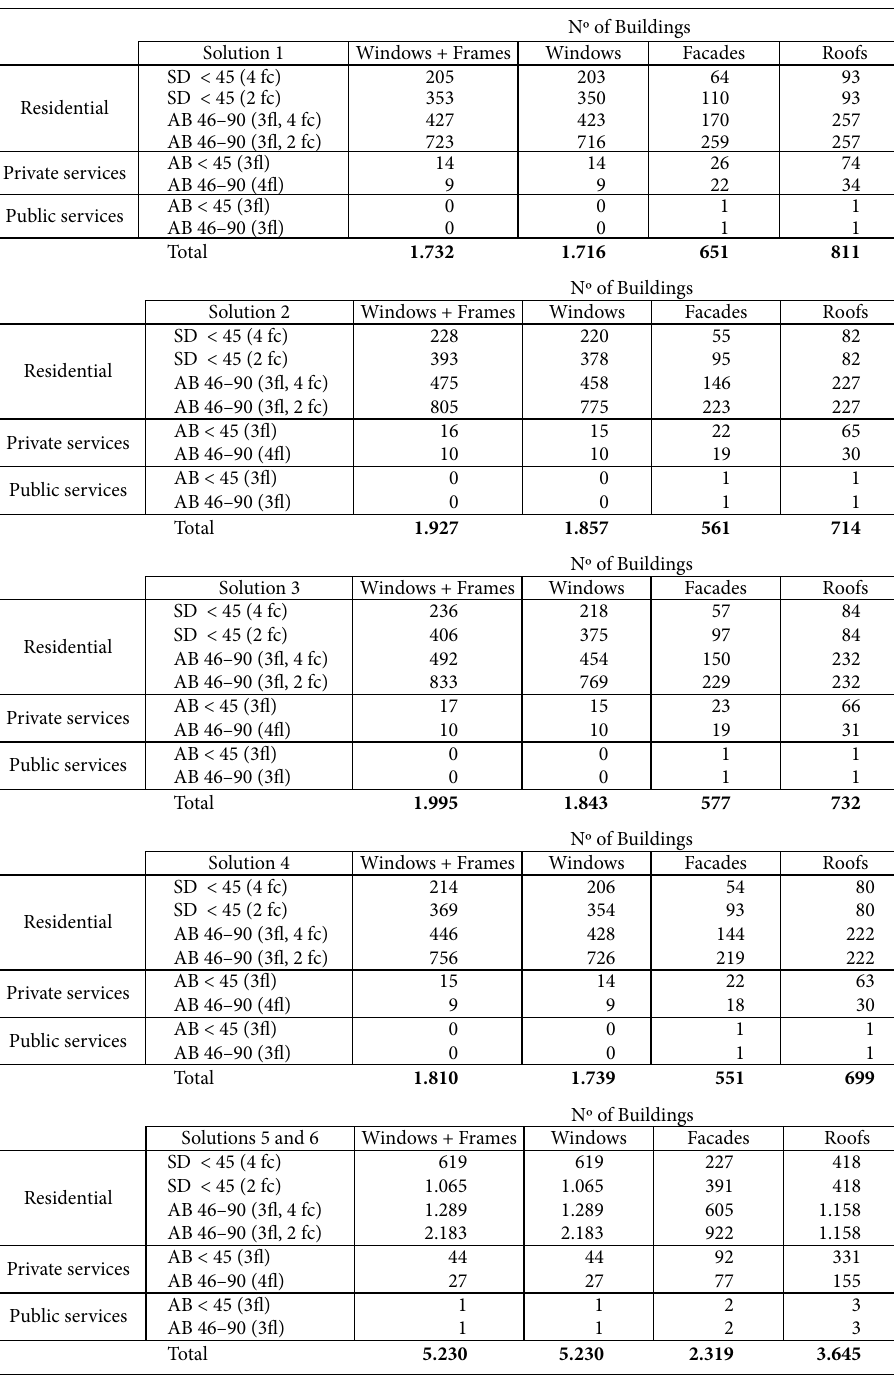
Fig. 5. Number of buildings subject to refurbishment interventions for the first six